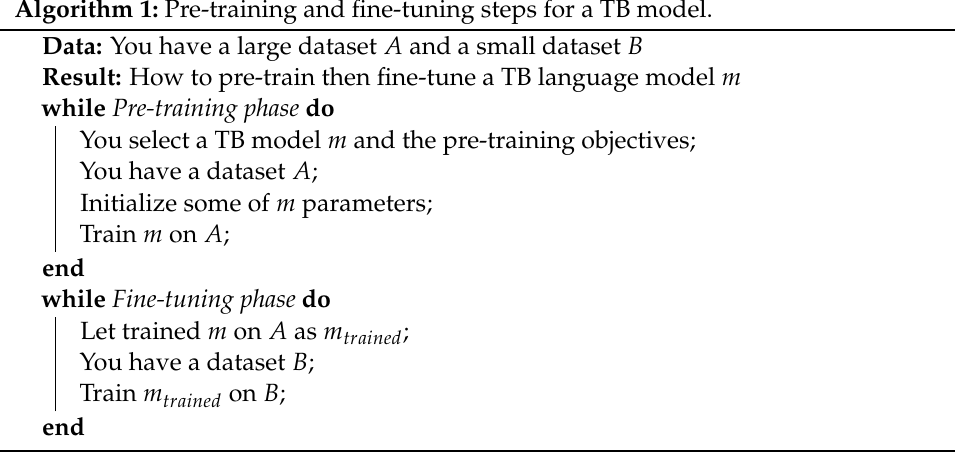
Algorithm 1 sums up the steps for the pre-training and fine-tuning framework. Algorithm 1: Pre-training and fine-tuning steps for a TB